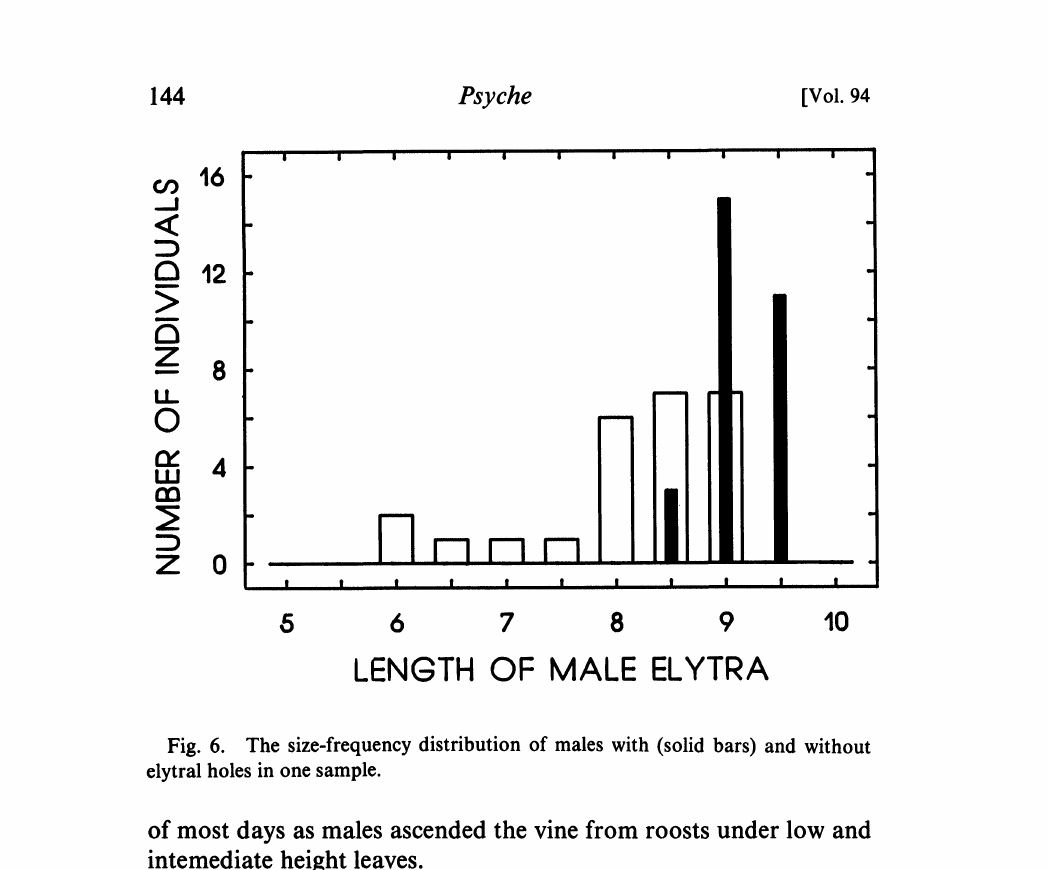
Fig. 6. The size-frequency distribution of males with (solid bars) and without elytral holes in one